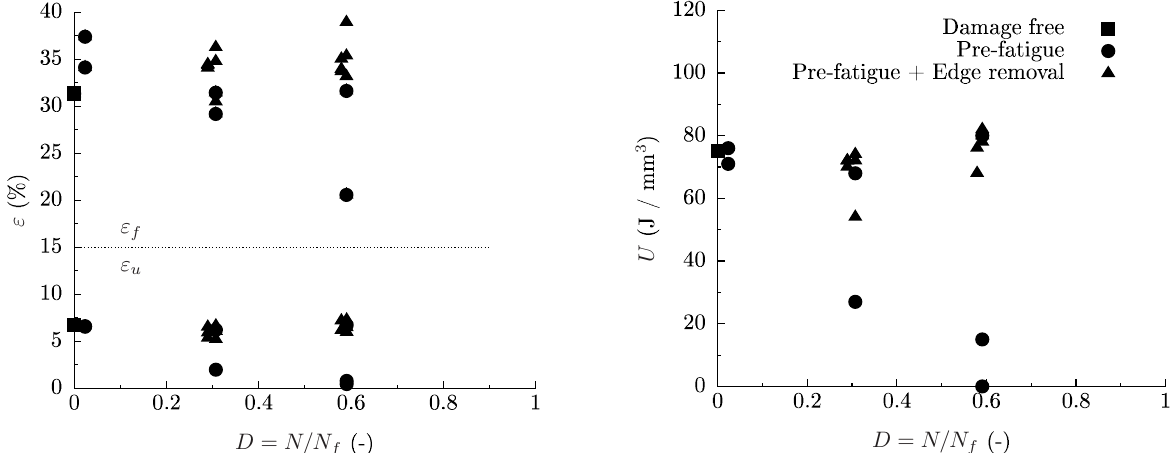
Fig. 10. Left: Uniform and fracture strain of damaged specimens. Right: Deformation energy absorbed during uniform